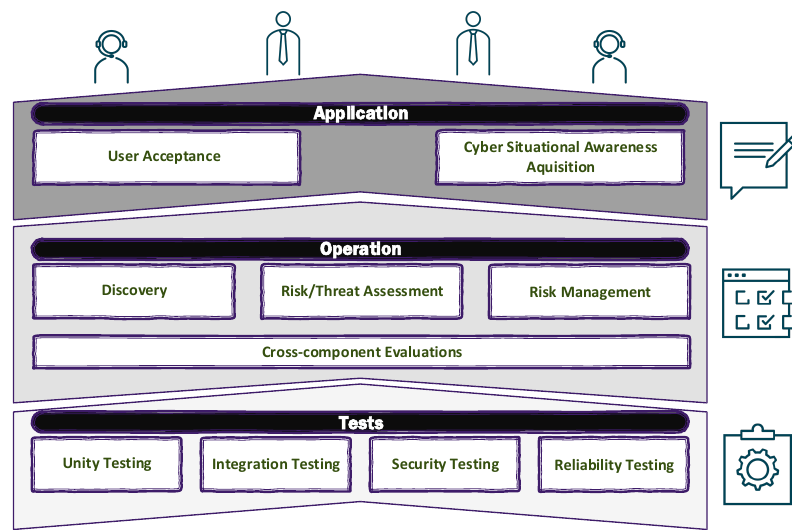
Figure 4. CSA verification and validation